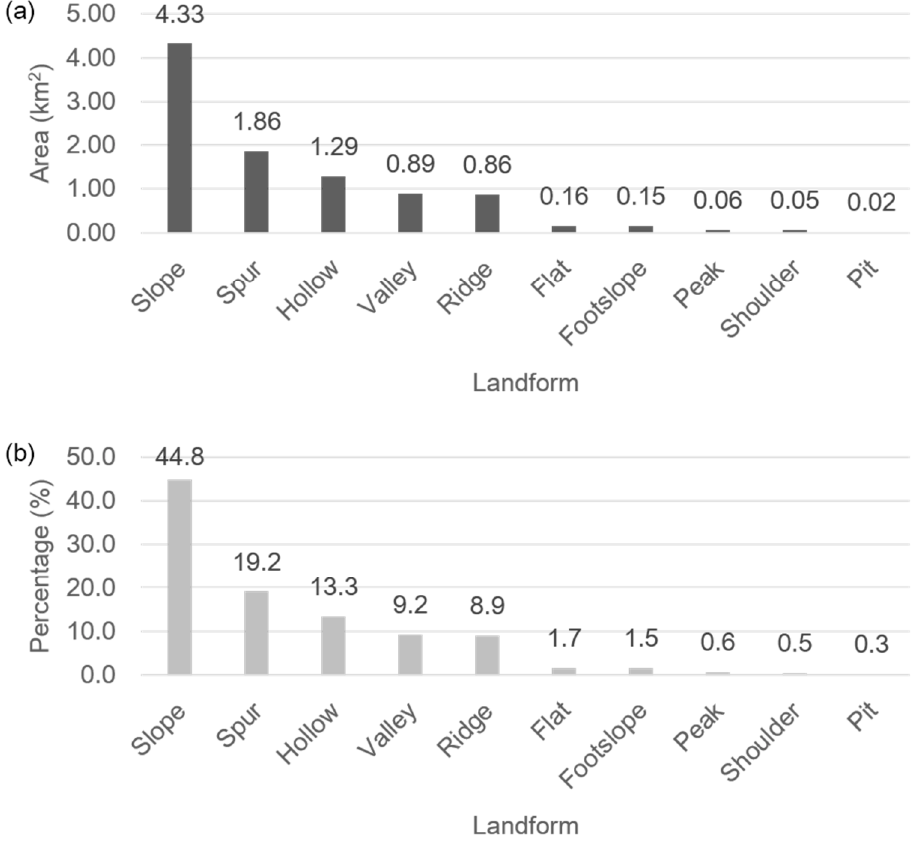
Figure 5. Landform of the change area. ( a ) area (km 2 ) and ( b ) percentage